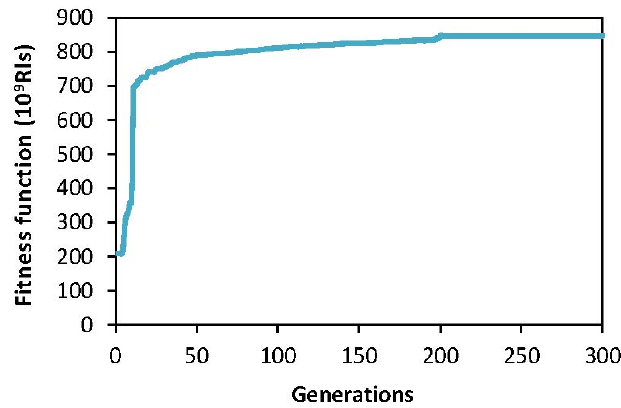
Figure 5. Fitness function for dry weather condition.